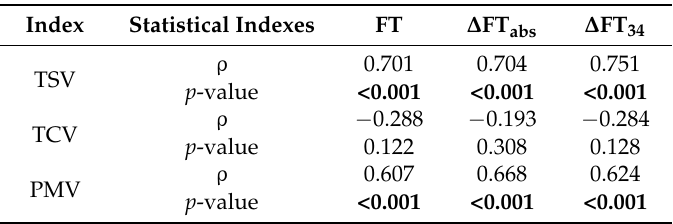
Table 4. Spearman’s correlations and p -values (in bold if statistically significant with respect to α =